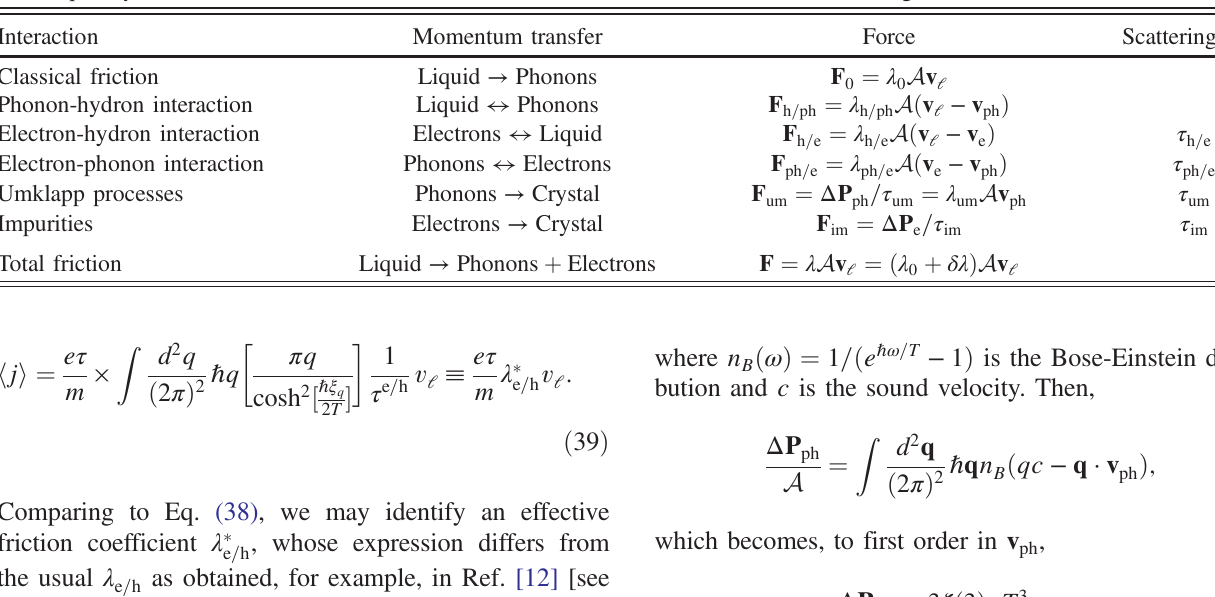
QUANTUM FEEDBACK AT THE SOLID-LIQUID INTERFACE: TABLE I. Forces in the solid-liquid system. List of interactions that may transfer momentum between the different components of the solid-liquid system, and notations for the associated forces, friction coefficients, and scattering times.